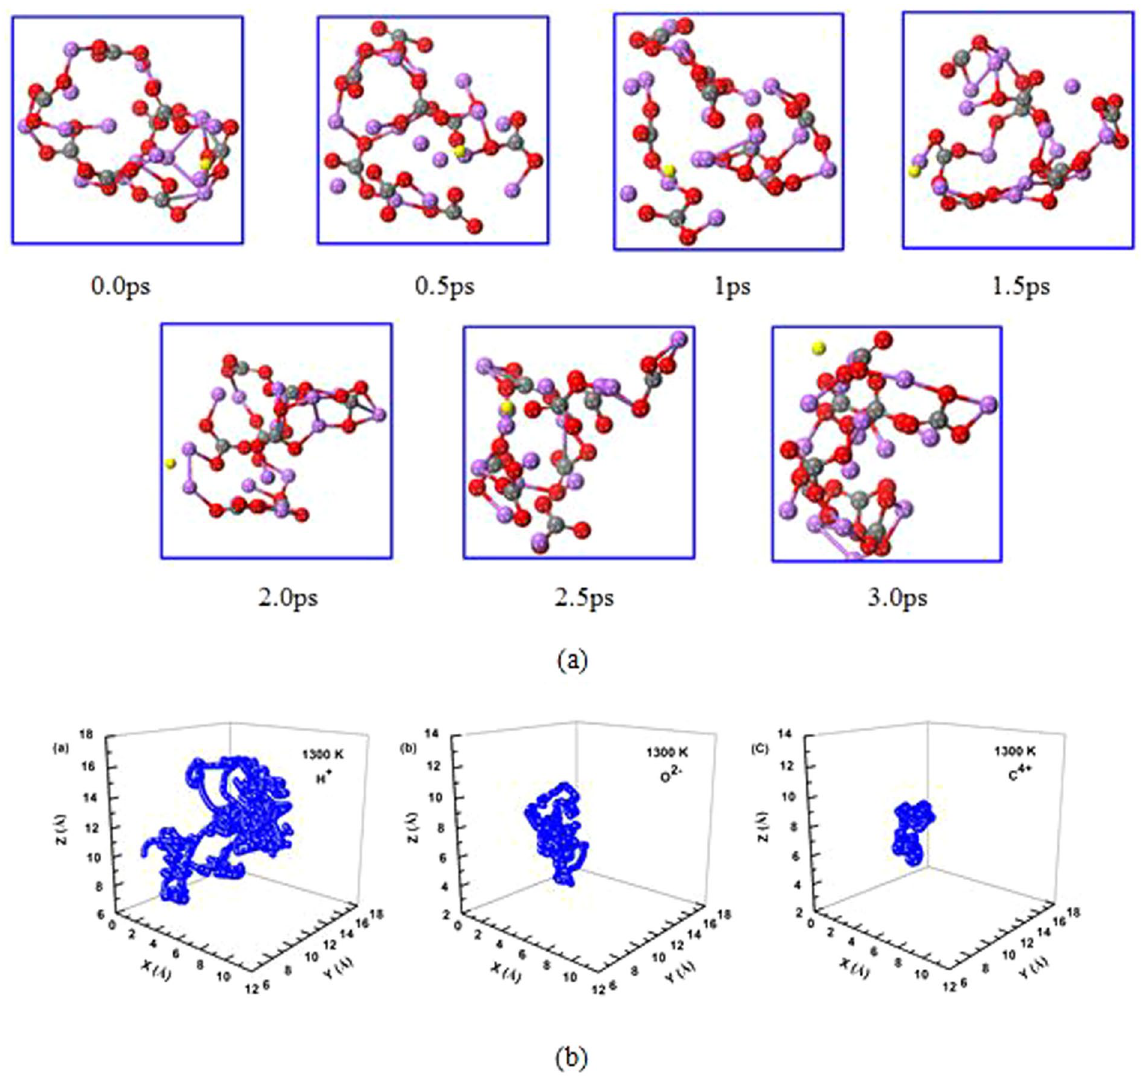
Figure 3. ( a ) Snap-shots for proton transfer in the cluster of (Li 2 CO 3 ) 8 simulated at 1300 K for 3 ps. The yellow ball represents the proton in motion. ( b ) Trajectory of proton, carbon, and oxygen ion in the cluster of (Li 2 CO 3 ) 8 simulated at 1300 K for 3